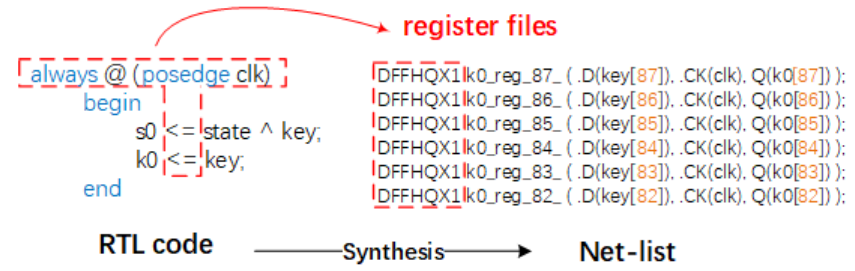
Figure 4. Synthesis results of sequential block in RTL